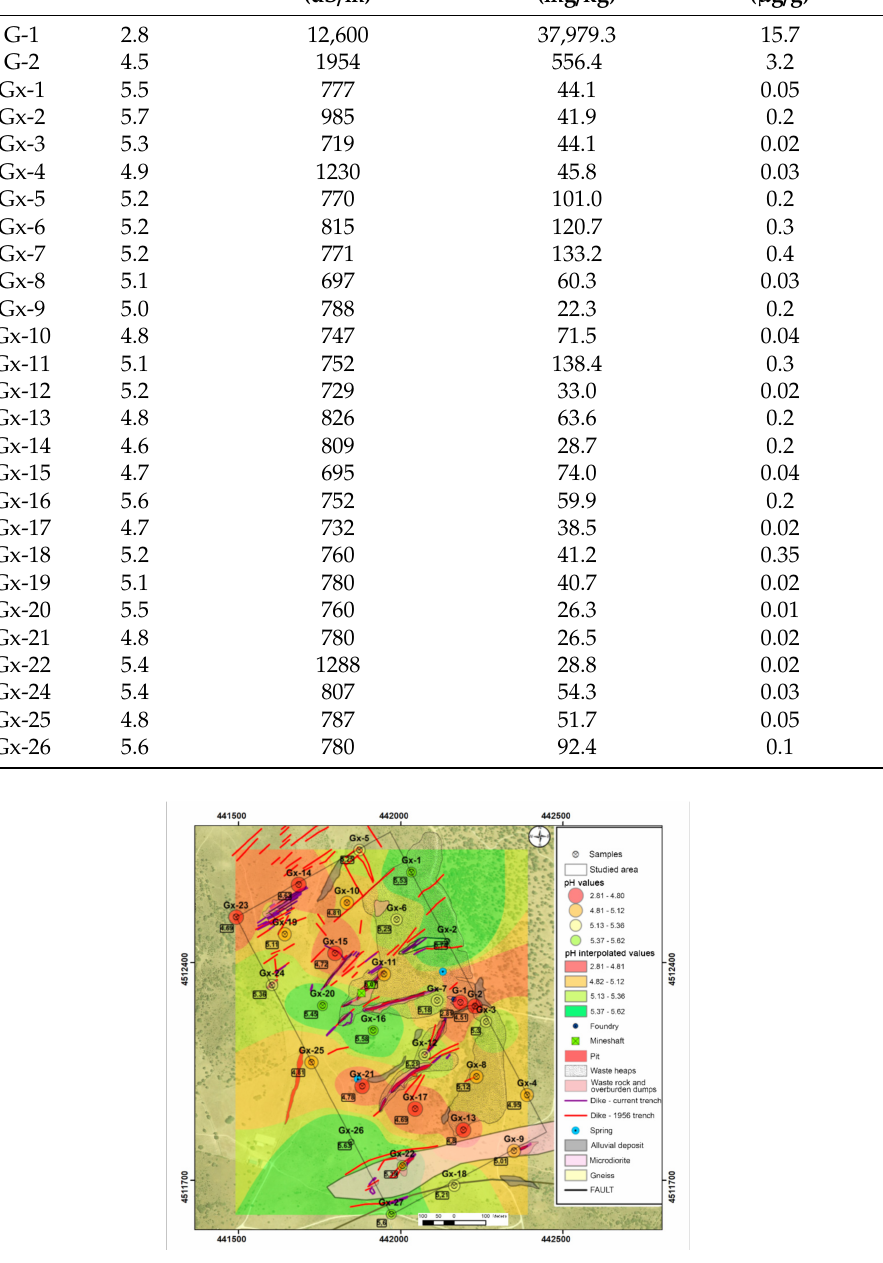
Figure 3. pH results in soil